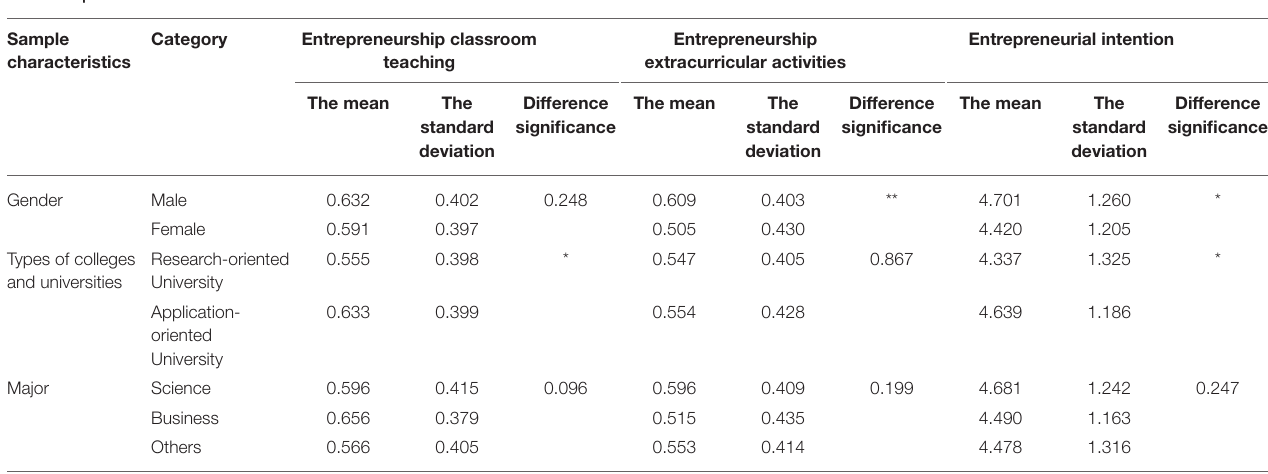
TABLE 5 | Difference test